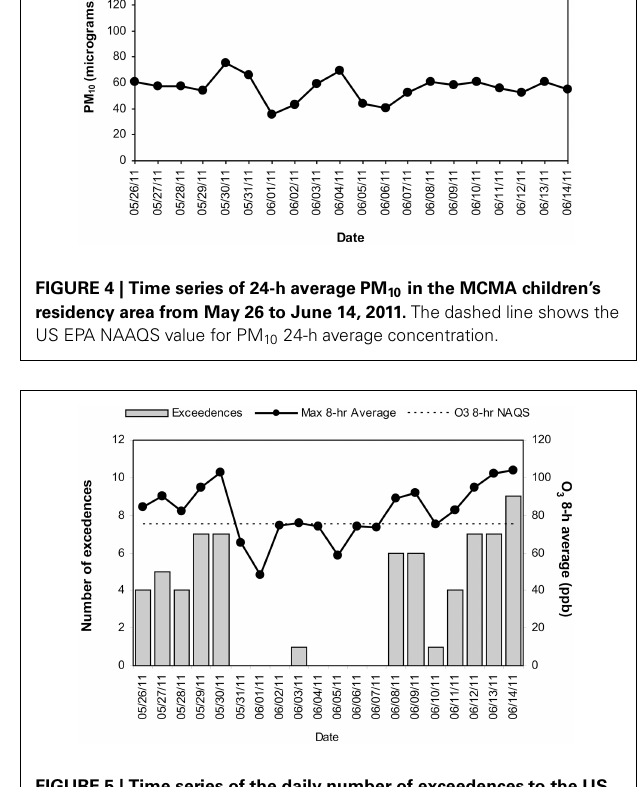
FIGURE 5 | Time series of the daily number of exceedences to the US EPA NAAQS value for the highest daily ozone 8-h average concentration and the respective daily maximum ozone 8-h average concentration in the children’s residency area from May 26 to June 14, 2011. The dashed line shows the ozone 8-h NAQS value as a